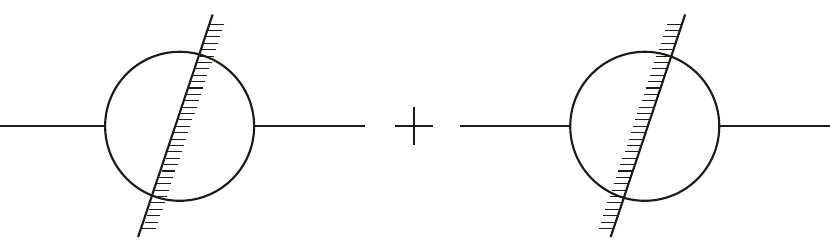
Figure 1 . Cut diagrams that give the imaginary part of